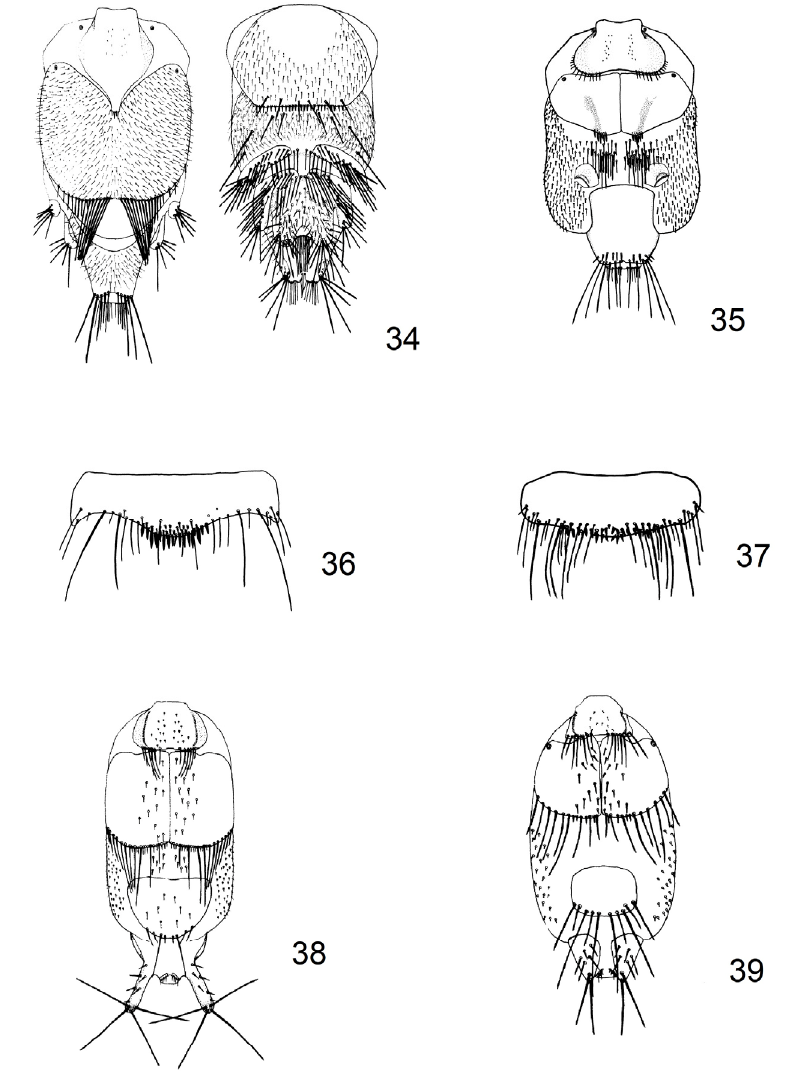
Figure 5. ( 34 ) Penicillidia ( Penicillidia ) conspicua Speiser, 1901, female, abdomen; ( 35 ) Penicillidia ( Penicillidia ) dufourii dufourii (Westwood, 1835), female, abdomen; ( 36 ) Phthiridium biarticulatum Hermann, 1804, male, sternite 5; ( 37 ) Phthiridium integrum (Theodor and Moscona, 1954), male, sternite 5; ( 38 ) Phthiridium biarticulatum Hermann, 1804, female, abdomen; ( 39 ) Phthiridium integrum (Theodor and Moscona, 1954), female, abdomen.